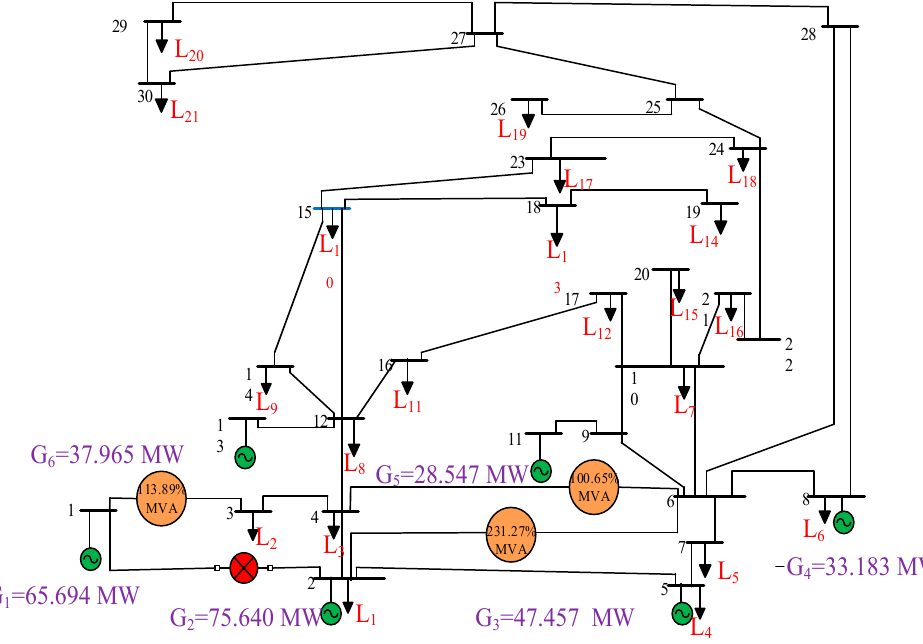
Figure 5. E ff ect of MVA violations due to an outage. Figure 5. Effect of MVA violations due to an outage. Table 1. Line flows in test case. Table 1. Line flows in test case.